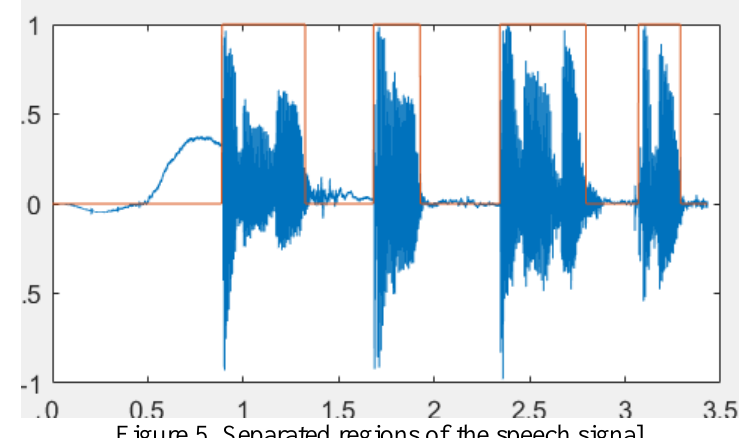
Figure 5. Separated regions of the speech